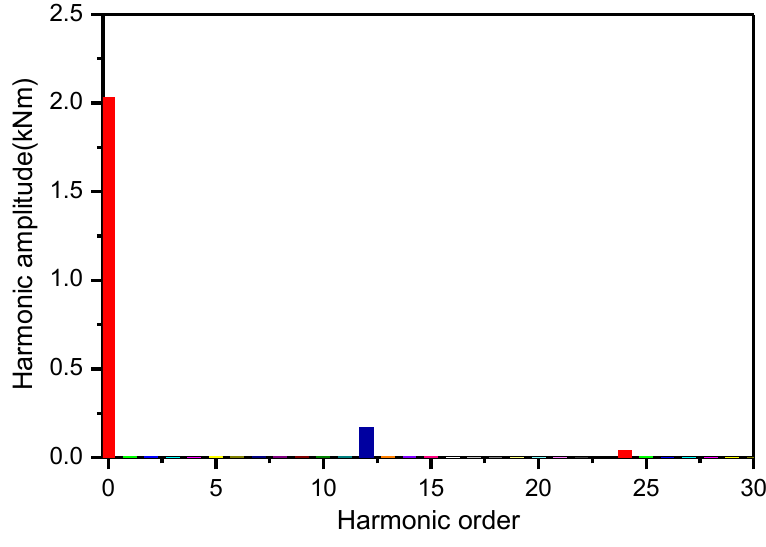
Figure 24. Harmonic analysis of steady-state torque.